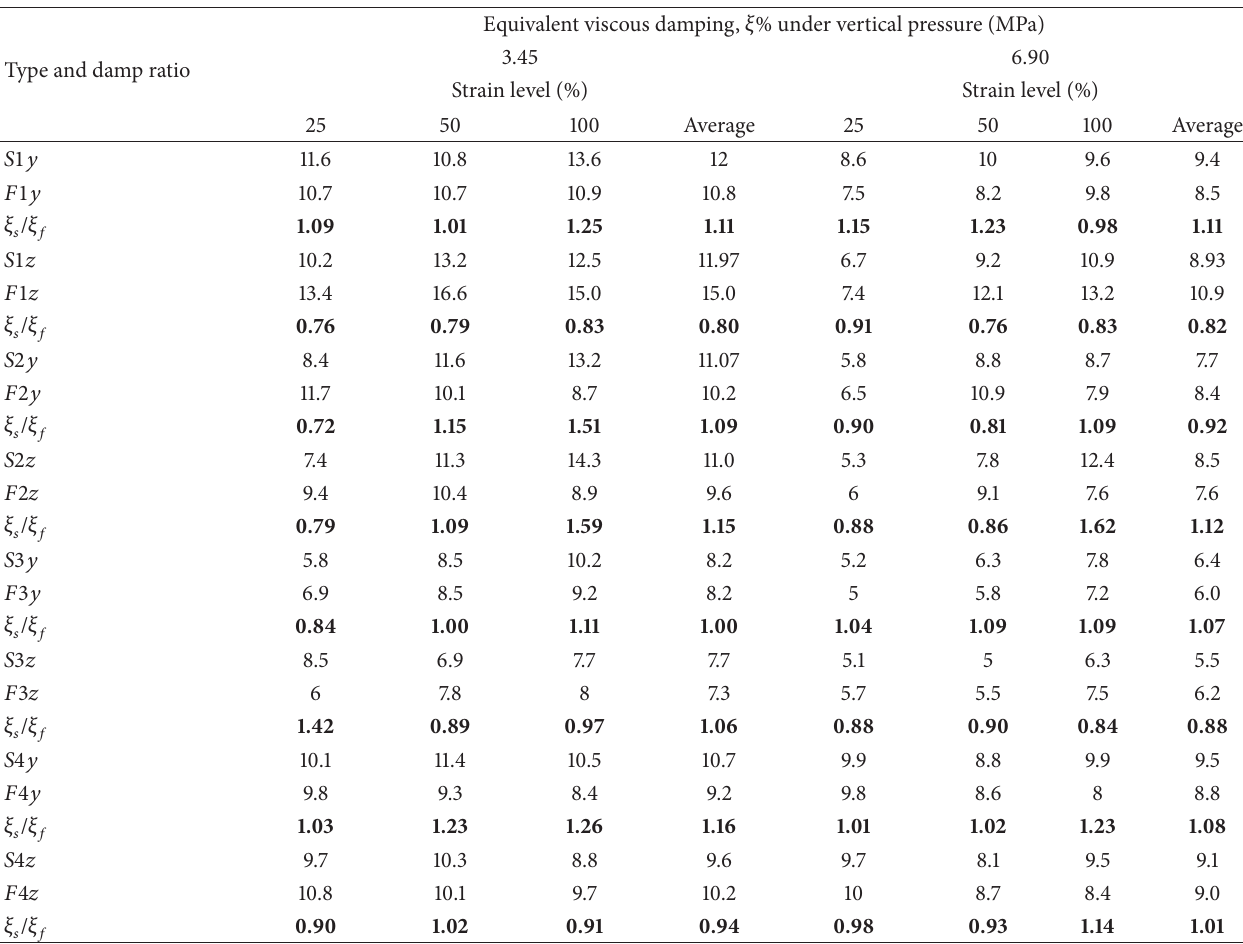
Table 2: Equivalent viscous damping